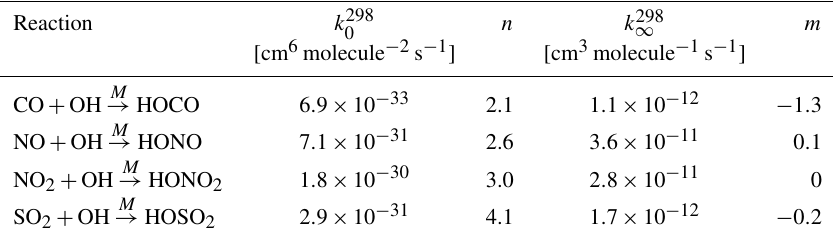
Table 3. Termolecular reaction rate coefficients for the hydroxyl radical. See Burkholder et al. (2019) for reference.